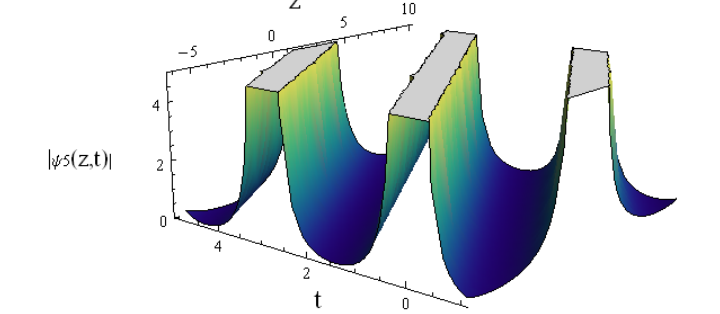
Figure 6. Change of solution (16) with z , t for c = 0.5, v = 0.7, β 1 = 0.05, β 2 = 1, β 3 = 0.3, β 4 = 0.2.